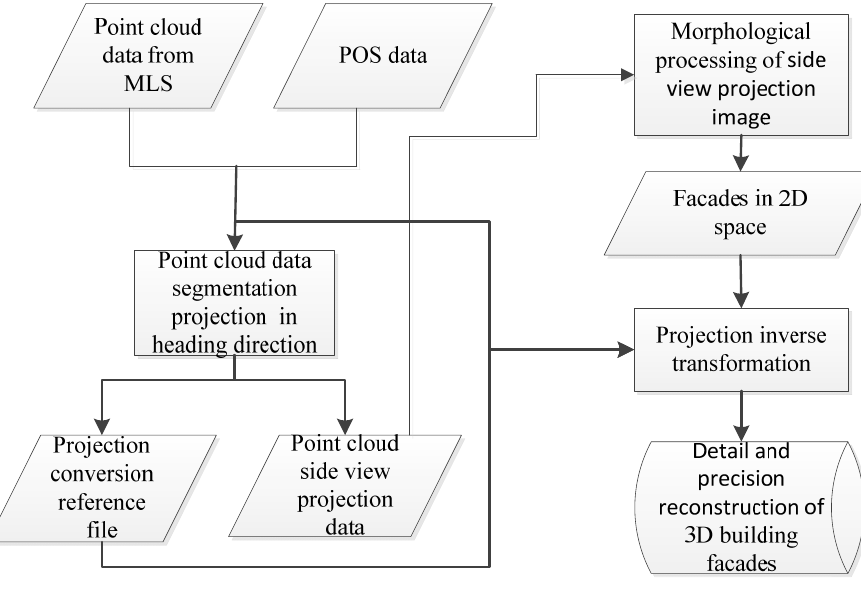
Figure 2. Algorithm Flow.